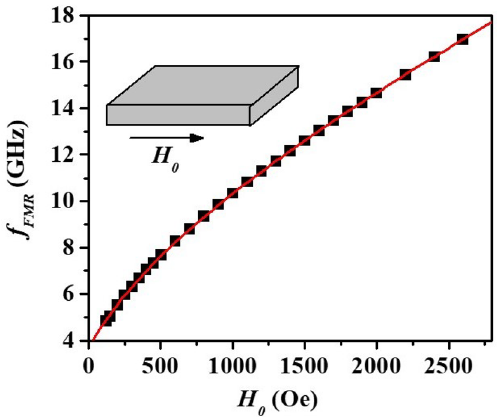
Figure 4. Resonance mode frequency as a function of bias field H for Zn 2 Y. These data were used for estimation of H